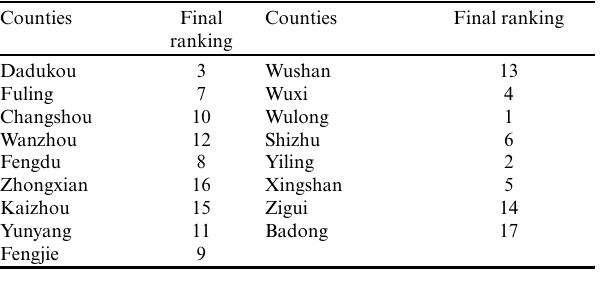
Table 9 . Final results.